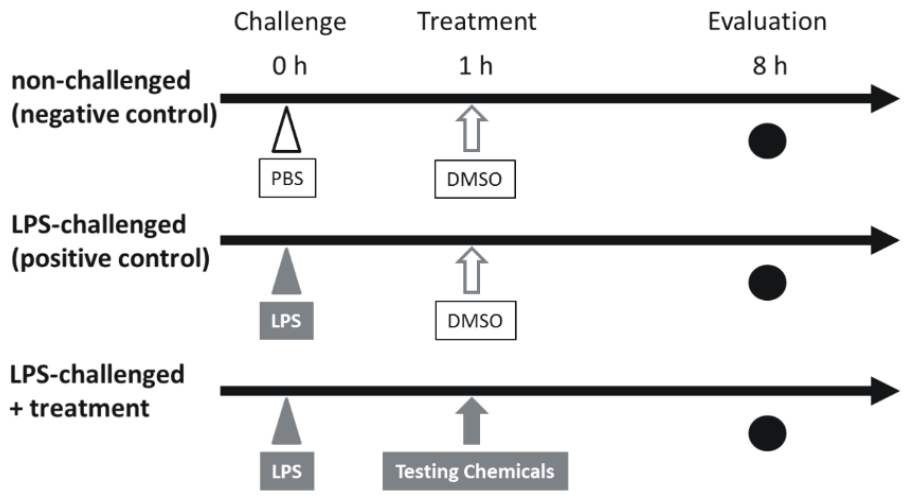
Figure 4. Verification protocols of LPS-challenged ALI-bearing rats treated with testing chemicals (APDs, paeonol, and dexamethasone).